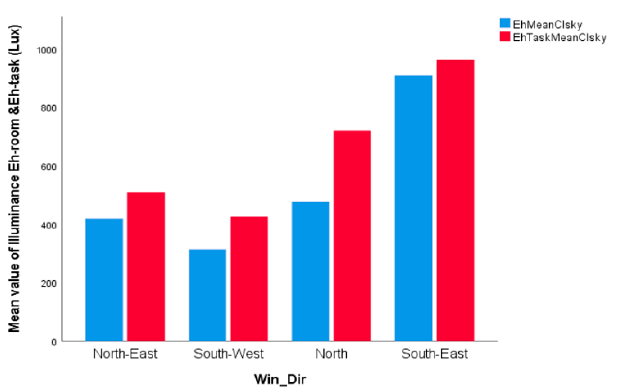
Figure 6. Overview of the results for the mean value of horizontal illuminance of the calculated sensor points of the room areas at work plane height.